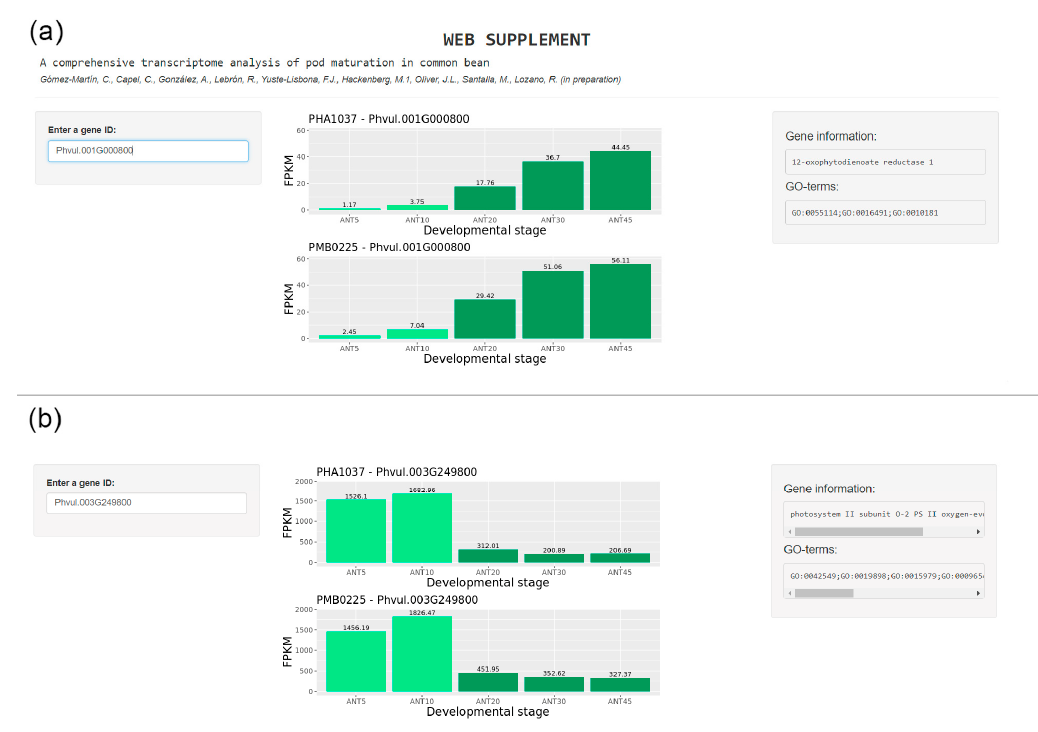
Figure 7. Working example of the Shiny webserver page showing the expression profiles of ( a ) up-regulated gene Phvul.001G000800 (12-oxophytodienoate reductase 1) and ( b ) down-regulated gene Phvul.003G249800 (photosystem II subunit O-2 PS II oxygen-evolving complex 1).